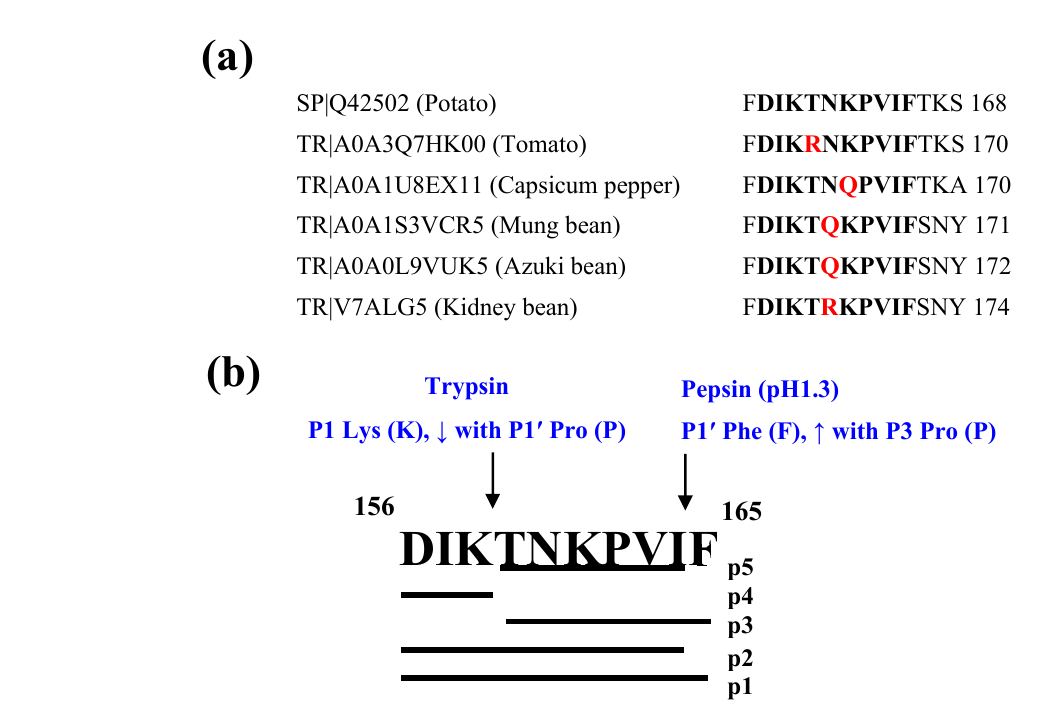
Figure 1. ( a ) Sequence alignment and location of DIKTNKPVIF or its variants on patatin sequences of potato and other plant-based foods retrieved from Swiss-Prot (SP) or TrEMBL (TR). Red letters indicate sequence variation relative to the potato patatin peptide sequence ( b ) Cleavage sites of two major gastrointestinal proteases on DIKTNKPVIF (f156–165; p1) resulting in the release of peptide fragments DIKTNKPVI (f156–164; p2), TNKPVIF (f159–165; p3), DIK (f156–158; p4) and TNKPVI (f159–164; p5).